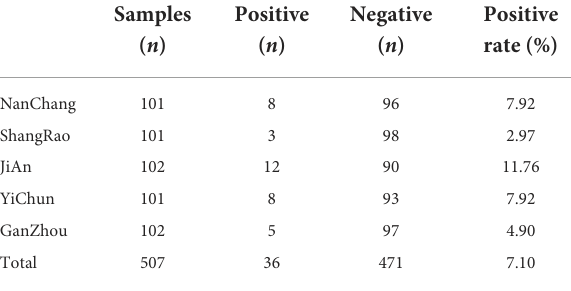
TABLE 3 The Rep antibody detection results by the ELISA from 507 serum samples. Samples